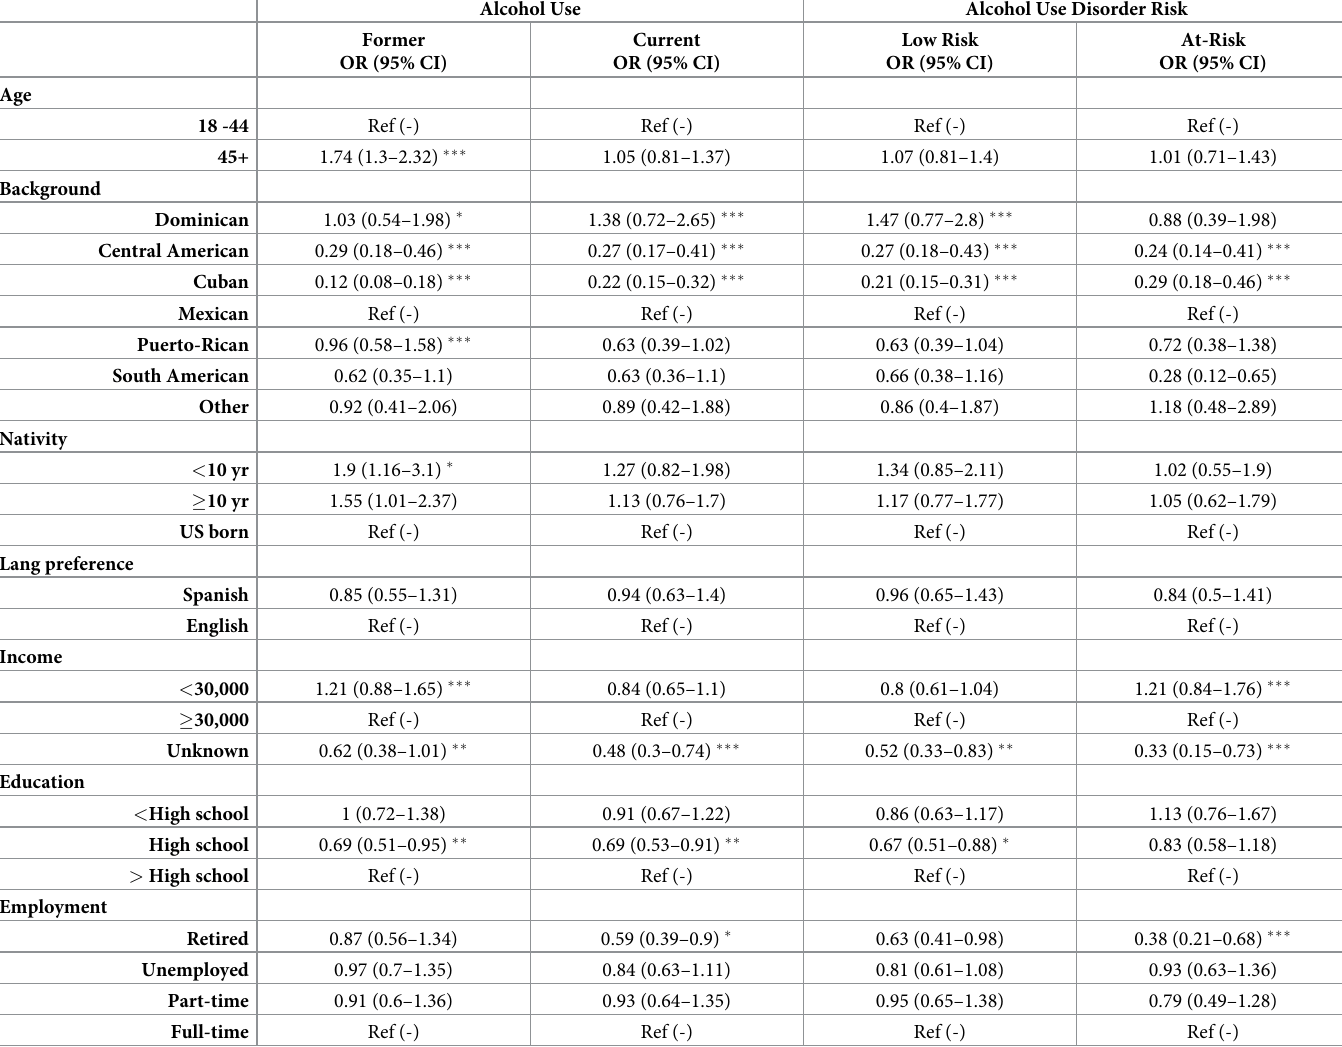
Table 3. Multinomial Logistic regression assessing the relationship between alcohol use and related risk behavior and socio-demographic variables and accultura- tion for men (n =